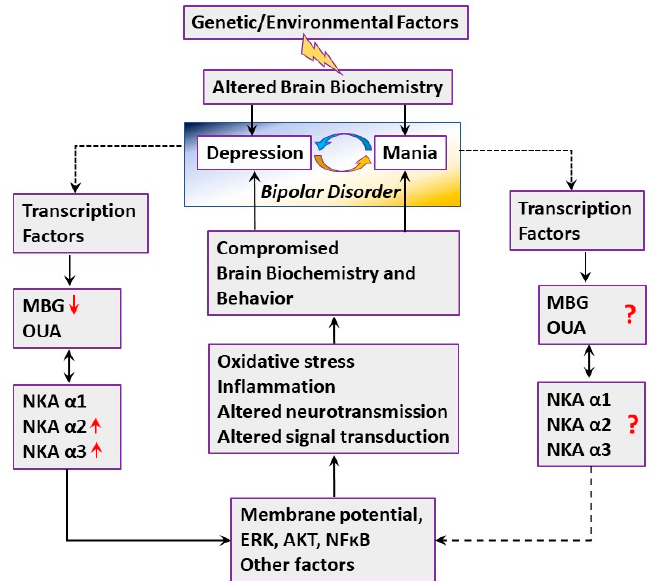
Figure 9. Proposed model for the participation of Na + , K + -ATPase and endogenous cardiac steroids in bipolar disorders. See text for detail. NKA-Na + , K + -ATPase; OUA—Ouabain; MBG— Marinobufagenin; ERK—mitogen-activated protein kinase; AKT—protein kinase B; NFkB—nuclear factor kappa-light-chain-enhancer.